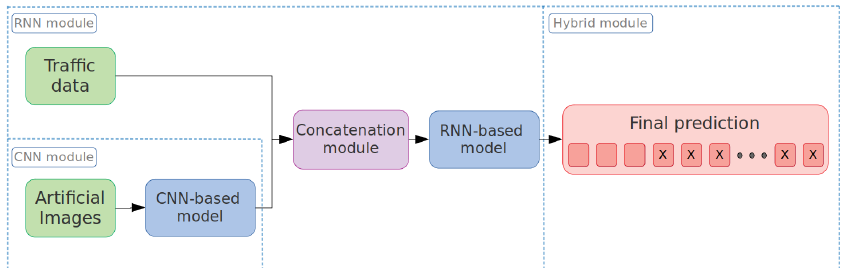
Figure 9. CNN-RNN hybrid model architecture. Green refers to the input information, blue to the DL model elements, purple to intermediate elements, and red to the output prediction.